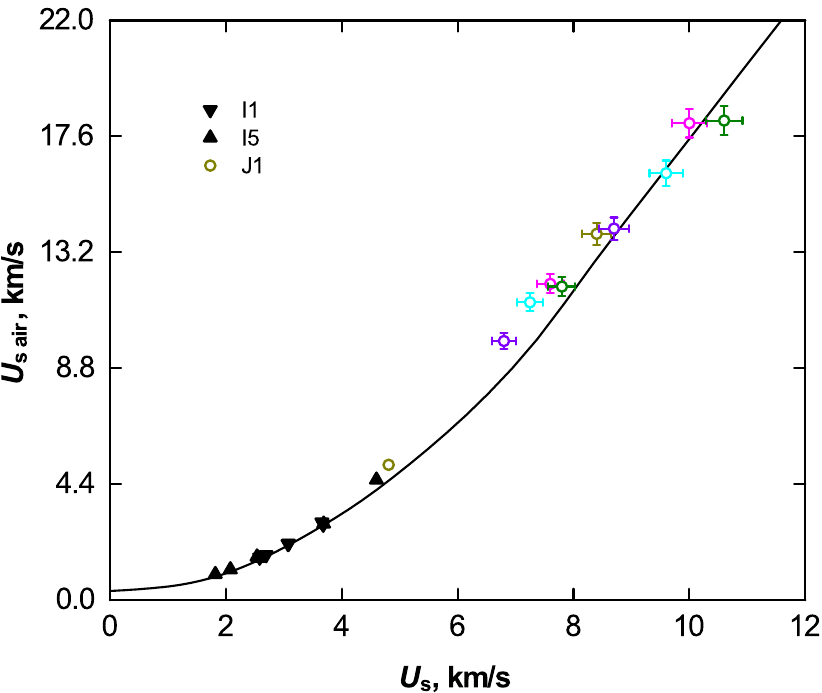
Figure 6. The shock velocity in air ( U sair ) as a function of the shock velocity in the bismuth samples ( U s ) when the shock front reaches the sample–gas interface: solid line—result of calculation using the present EOS of bismuth and the shock adiabat of air taken from [71]; markers—experimental data